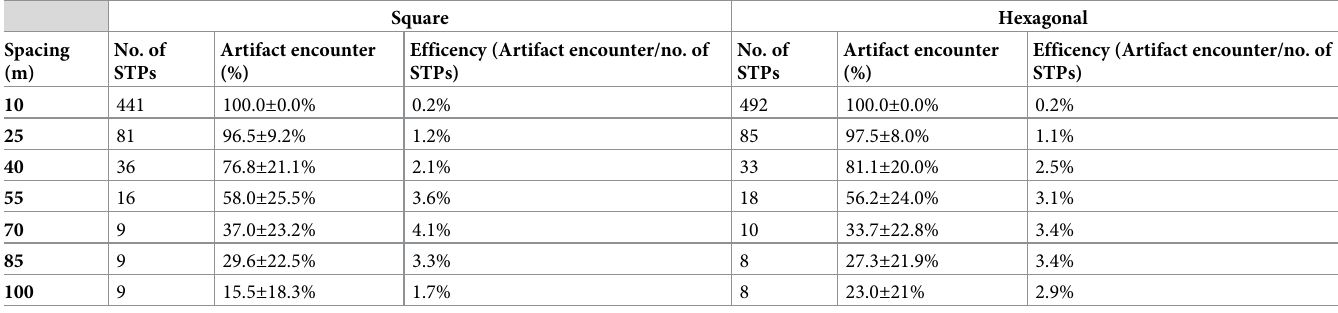
Table 2. Effectiveness and efficiency of square and hexagonal grids with 100–10 m